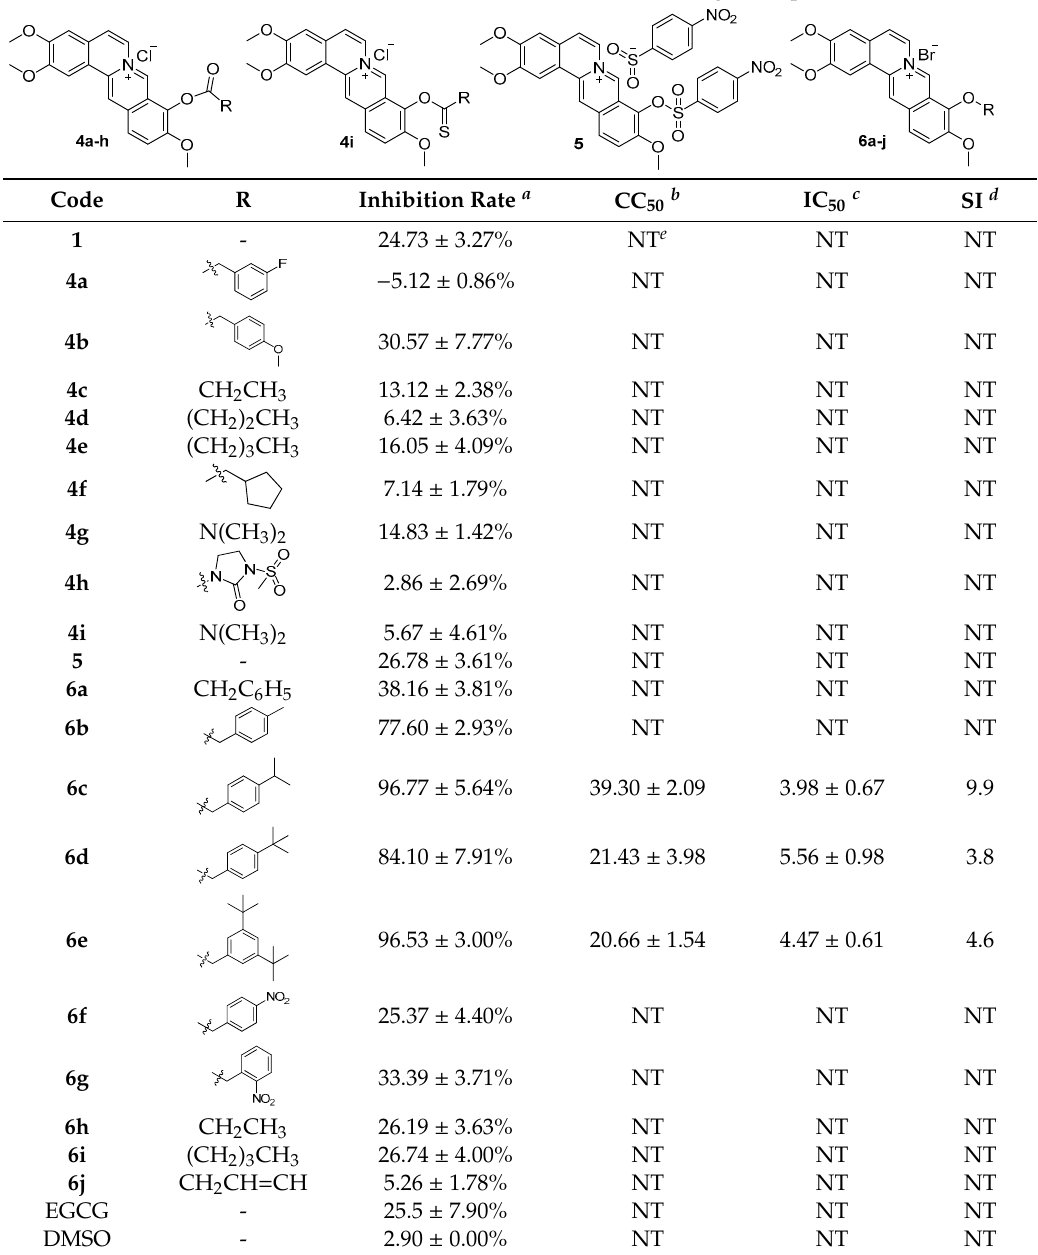
Table 1. Structures and Inhibition effects on COL1A1 of target compounds.